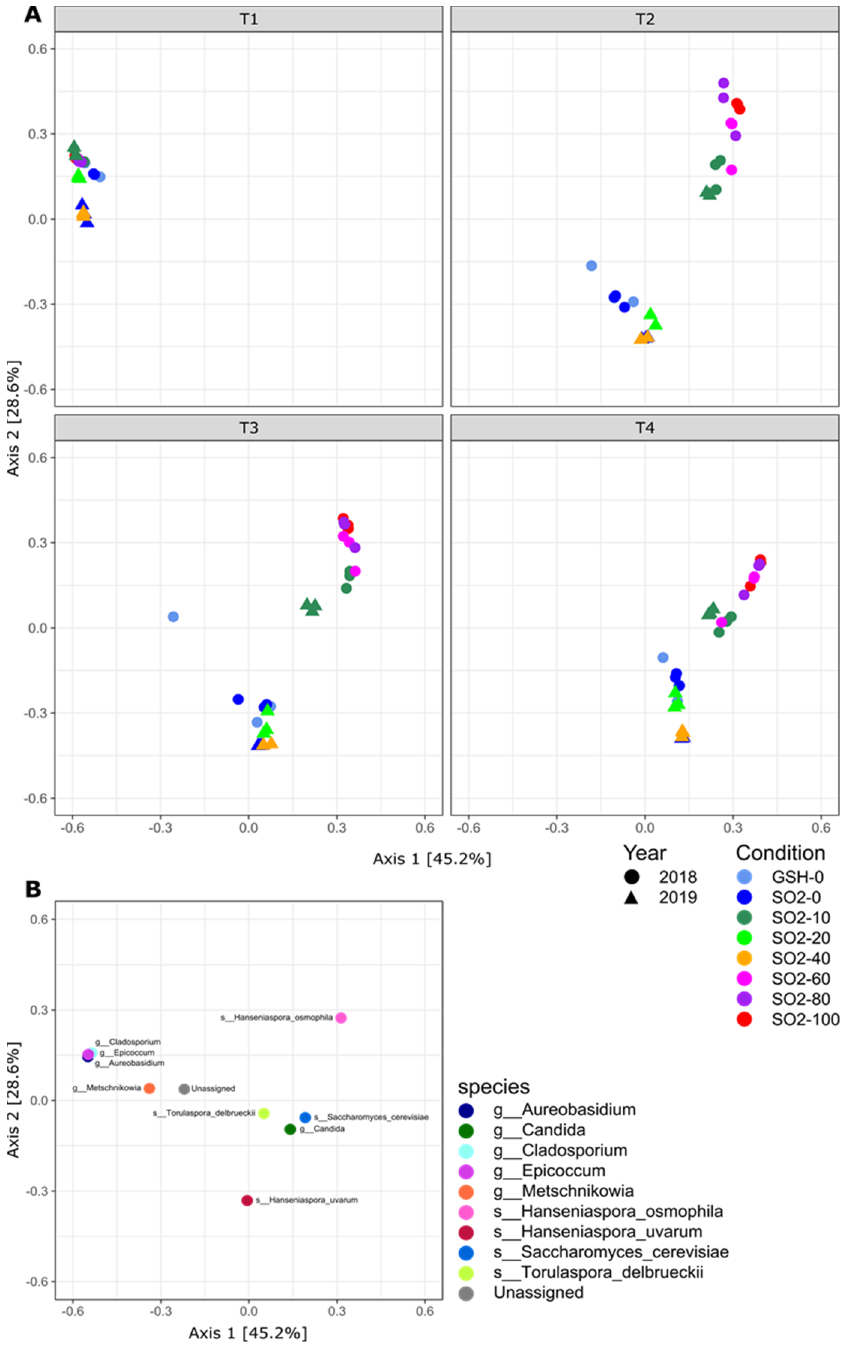
Figure 5. Dissimilarity analysis of ITS-amplicon abundance from vintage 2018 and 2019 fermentations. ( A ) Triplicate samples from each time point were subjected to Bray–Curtis dissimilarity analysis (clustered by PCoA) based upon the top 10 most abundant species and are shaded by treatment condition. ( B ) The weightings of the top 10 most abundant species relative to the plots in part ( A ). Points are shaded by species. For those OTU where a species-level designation was not possible, the genus-level taxonomic classification of the OTU was used.